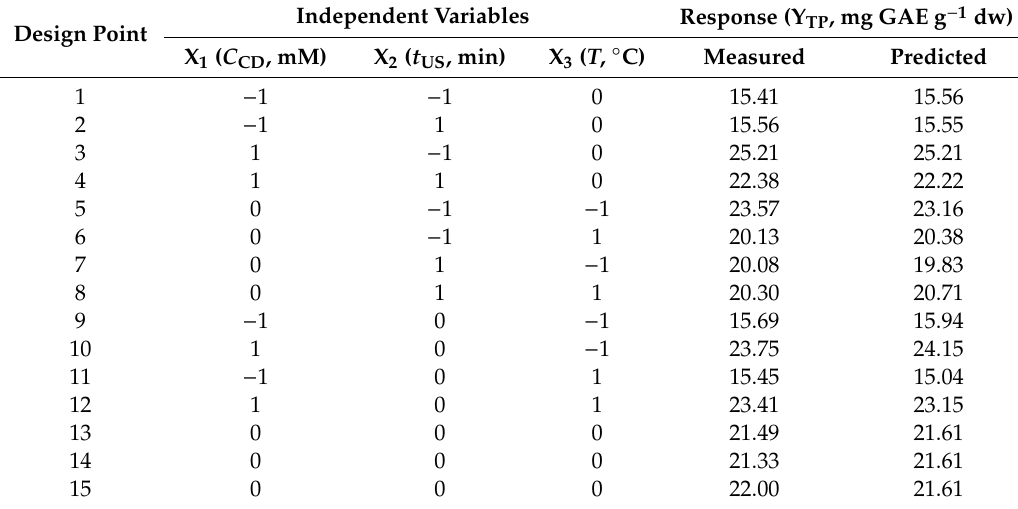
Table 2. Analytical presentation of the design points of the response surface methodology and the corresponding measured and predicted response